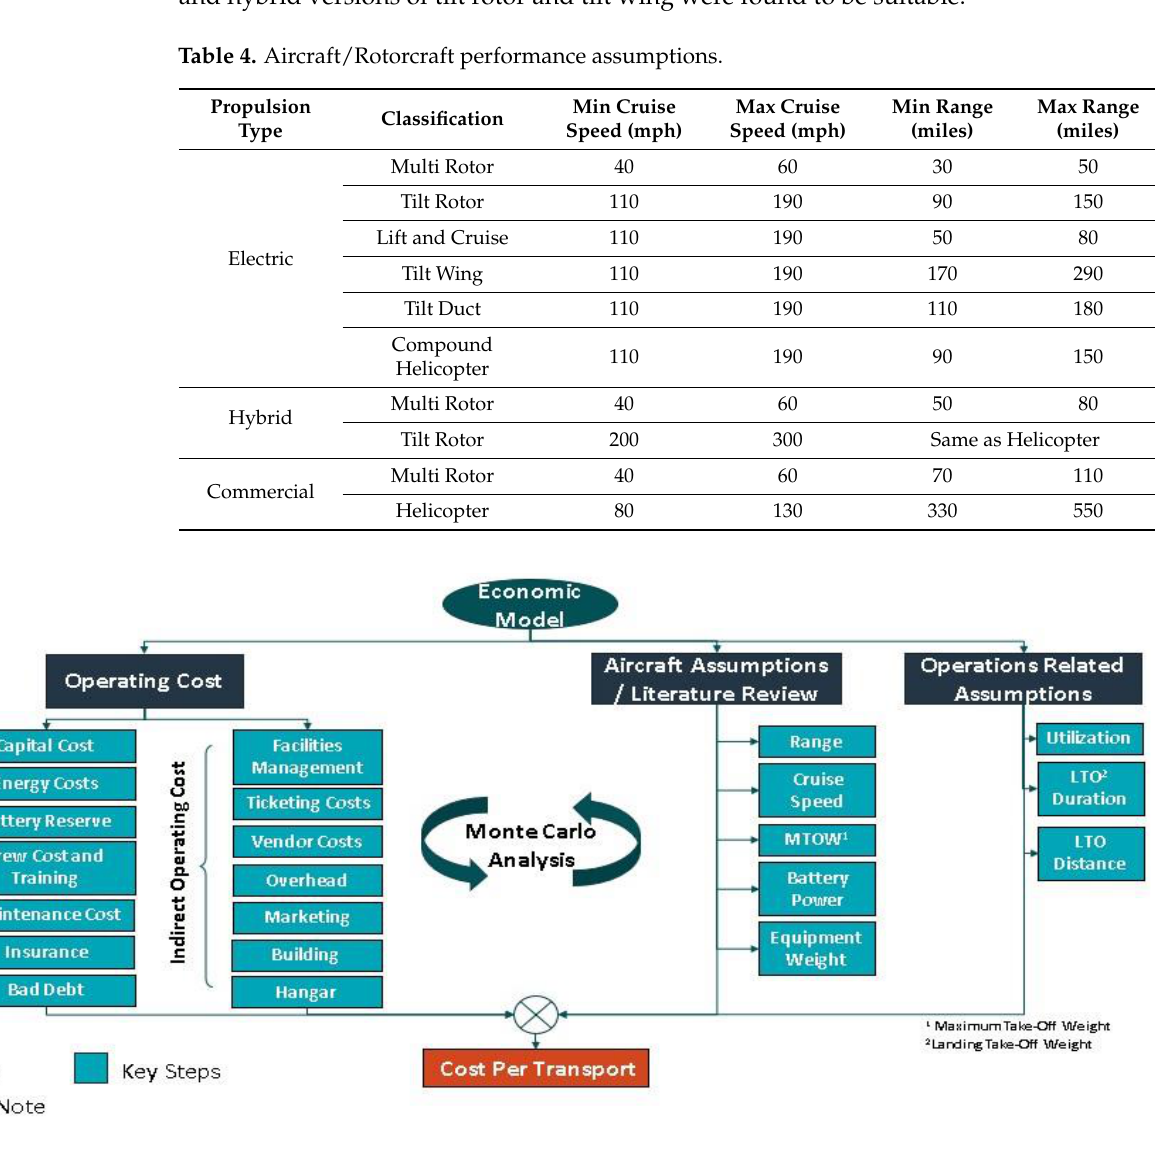
Figure 3. Supply economic model for an air